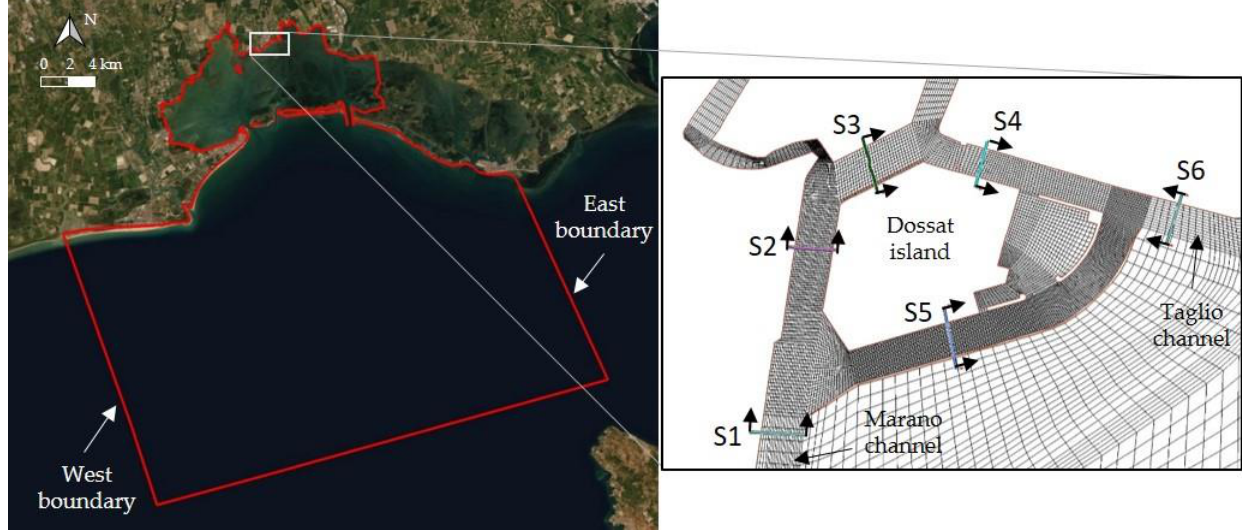
Figure 5. Morphodynamic computational mesh: mesh boundaries and a detail of the grid of the port of Marano, with the indication of the cross sections used in the following.